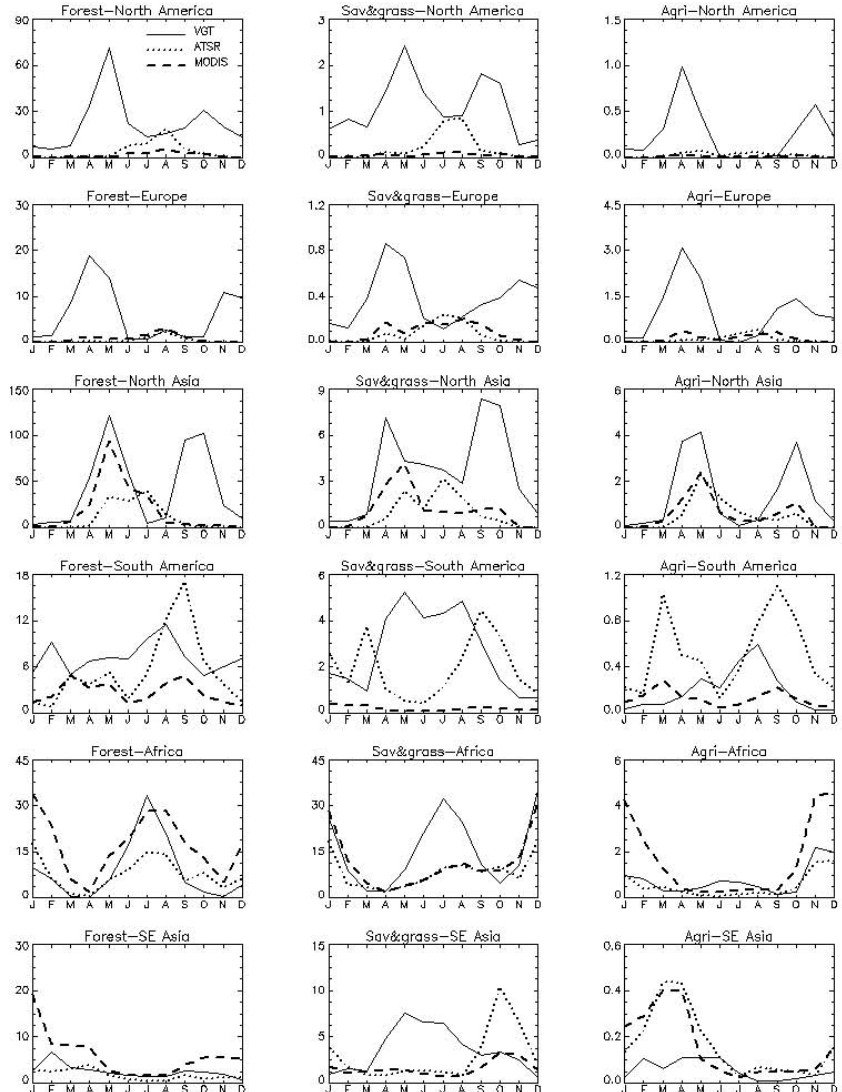
Fig. 3. Seasonality of CO emissions [Tg CO month − 1 ] for the six continental windows and the three broad land cover types (forest, savanna/grassland and